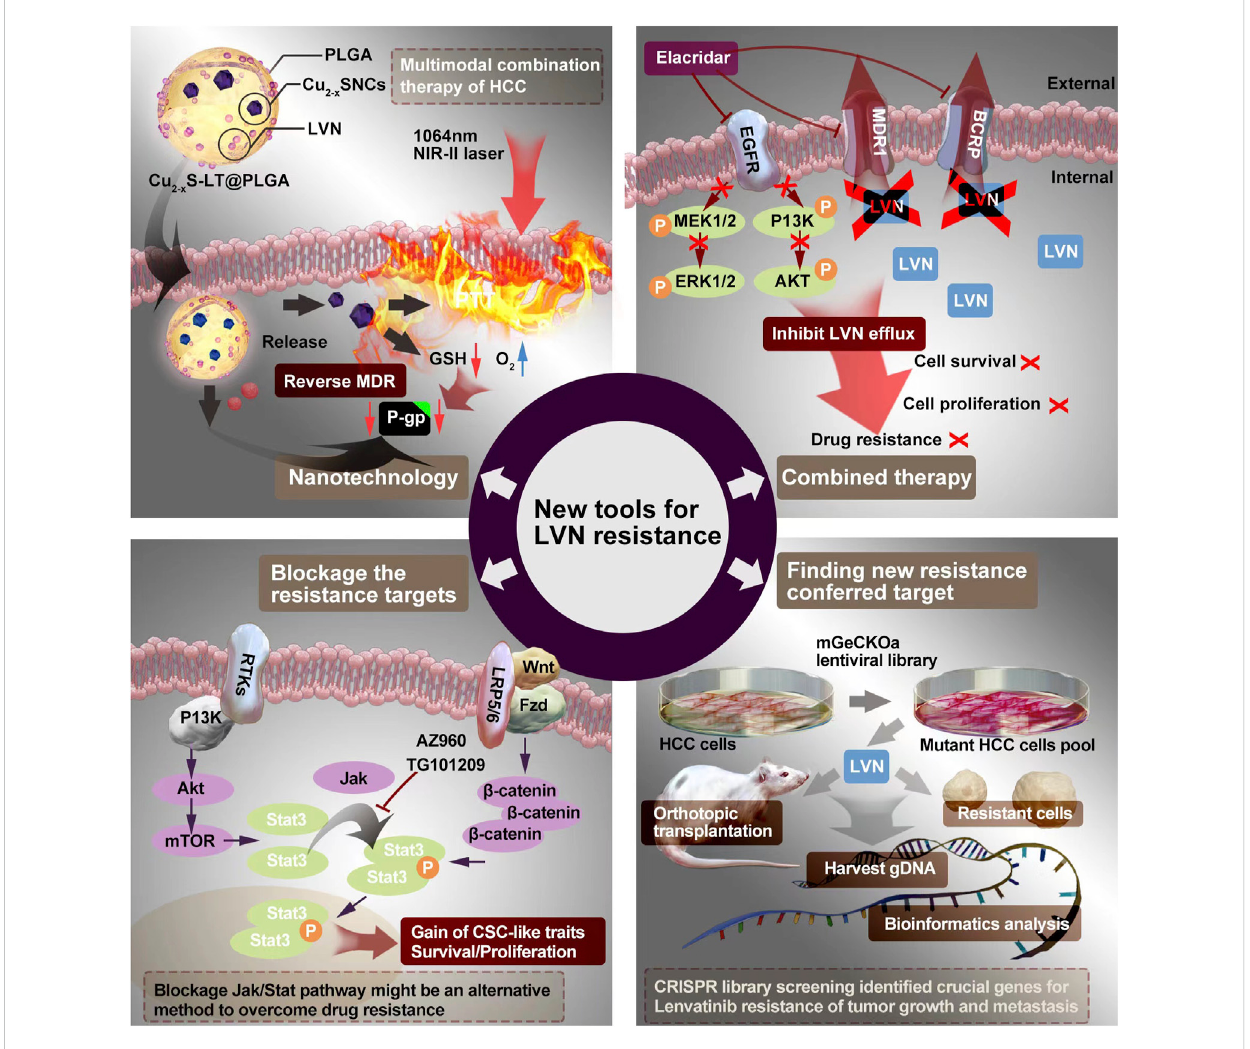
FIGURE 4 The potential ways to conquer LVN ’ s resistance containing the nanotechnology, combination therapy, blockage the resistance target and fi nding new target.